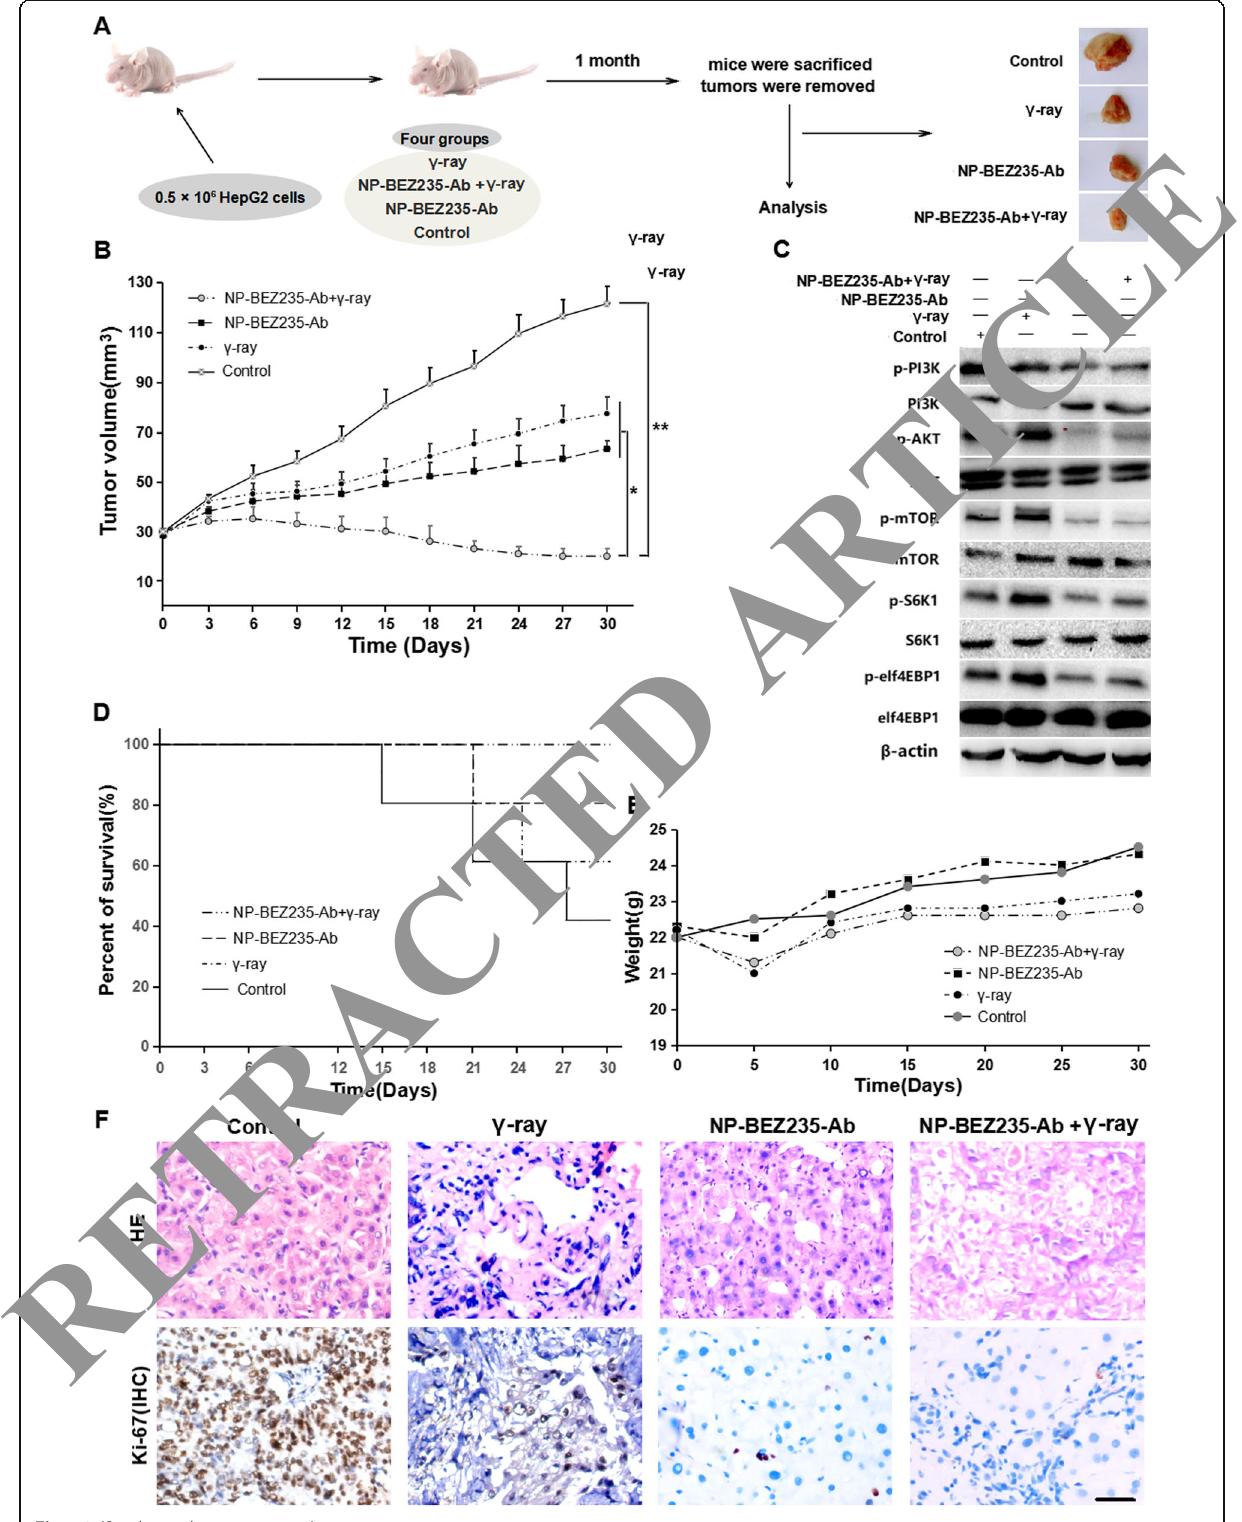
Fig. 10 (See legend on next